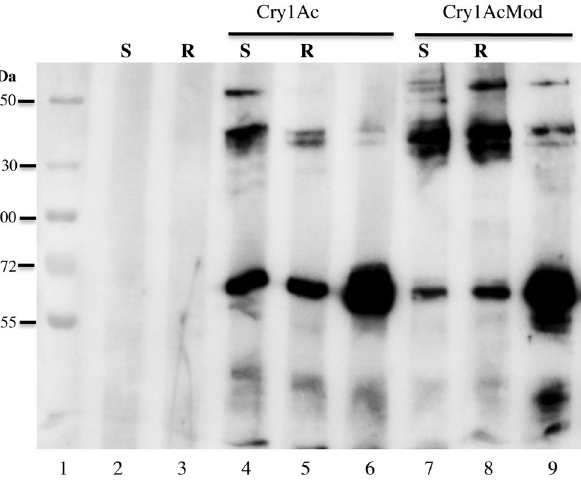
Figure 2. Oligomerization of Cry1Ac and Cry1AcMod in BBMV from susceptible and resistant populations of P. xylostella . Cry1Ac or Cry1AcMod activated toxins (1.5 μ g) were incubated with BBMV (20 μ g) from P. xylostella susceptible Geneva 88 or resistant NO-QAGE, BBMV were recovered by centrifugation and separated by SDS-PAGE after three min heating at 60 °C and revealed in western blot using anti-Cry1Ac antibody as described in Experimental procedures. Lane 1 shows Molecular weight marker; lane 2, BBMV from Geneva 88 without toxin; lane 3, BBMV from NO-QAGE without toxin; lane 4, BBMV from Geneva 88 with Cry1Ac toxin; lane 5, BBMV from NO-QAGE with Cry1Ac toxin; lane 6 is a control of activated Cry1Ac toxin directly loaded in the SDS-PAGE; lane 7, BBMV from Geneva 88 with Cry1AcMod toxin; lane 8, BBMV from NO-QAGE with Cry1AcMod toxin and lane 9 is a control of activated Cry1AcMod toxin directly loaded in the